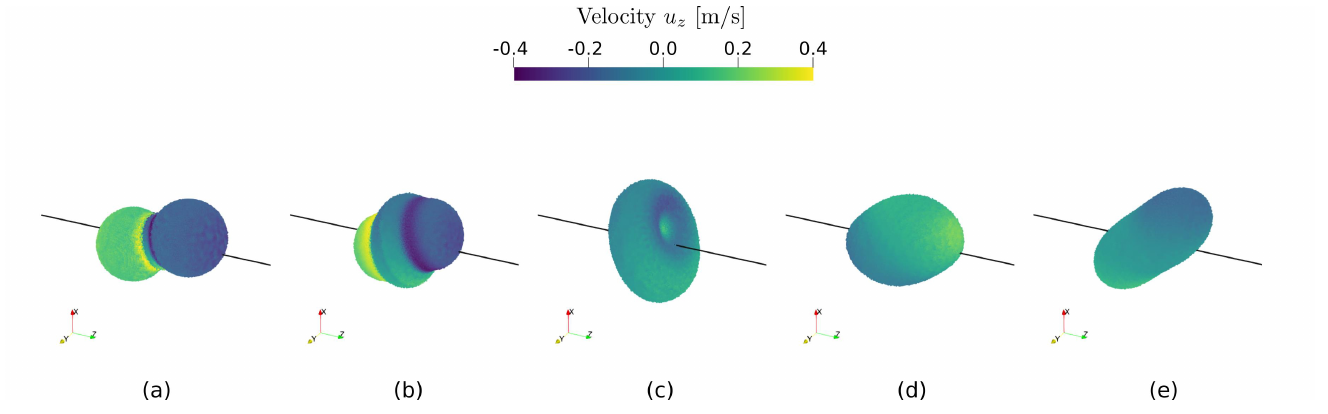
Figure 14. Droplet collision for Re = 250, We = 8, and ρ 1 : ρ 2 = 1000 : 1 at ( a ) t = 0.25 s, ( b ) t = 1 s, ( c ) t = 2.75 s, ( d ) t = 5 s, and ( e ) t = 7.5 s.